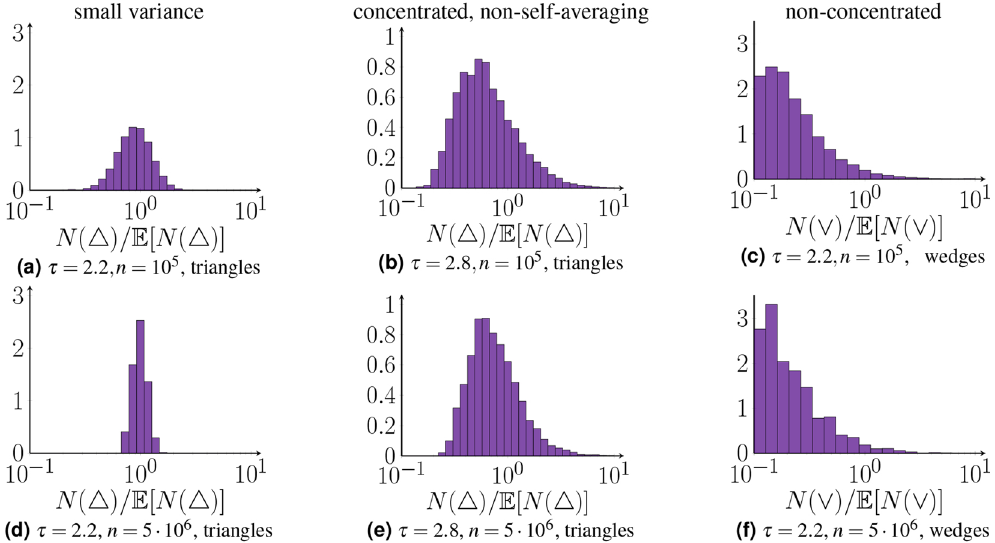
Figure 4. Density approximation of the normalized triangle and wedge counts for various values of τ and n , obtained over 10 4 network samples.